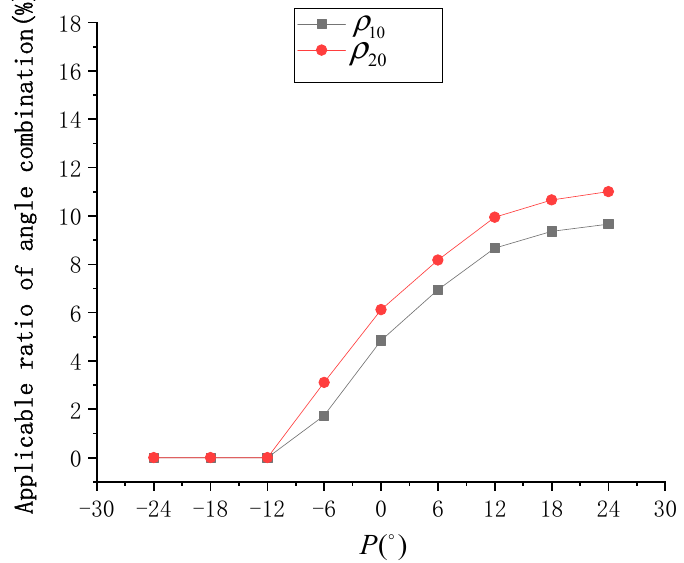
ρ ρ ff erent pointing angles ( P 20 at di 10 and